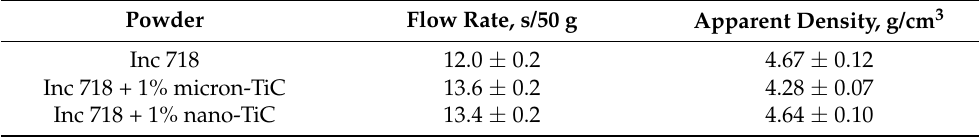
Table 2. Technological properties of the